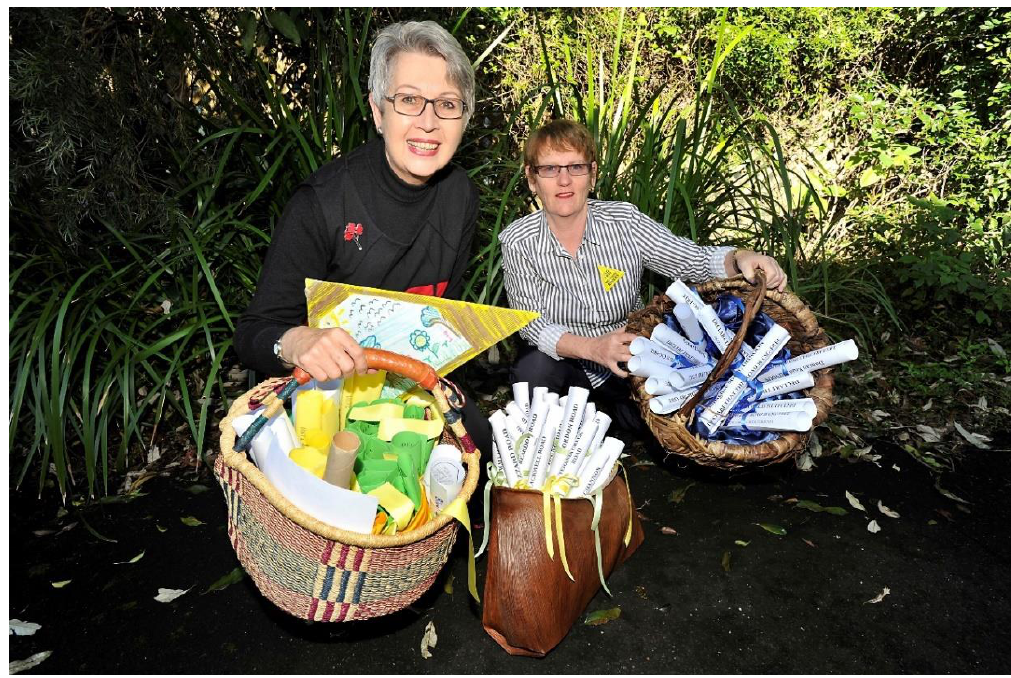
Figure 2: Lismore mayor Jenny Dowell and Annie Kia holding baskets full of ‘CSG-free’ community